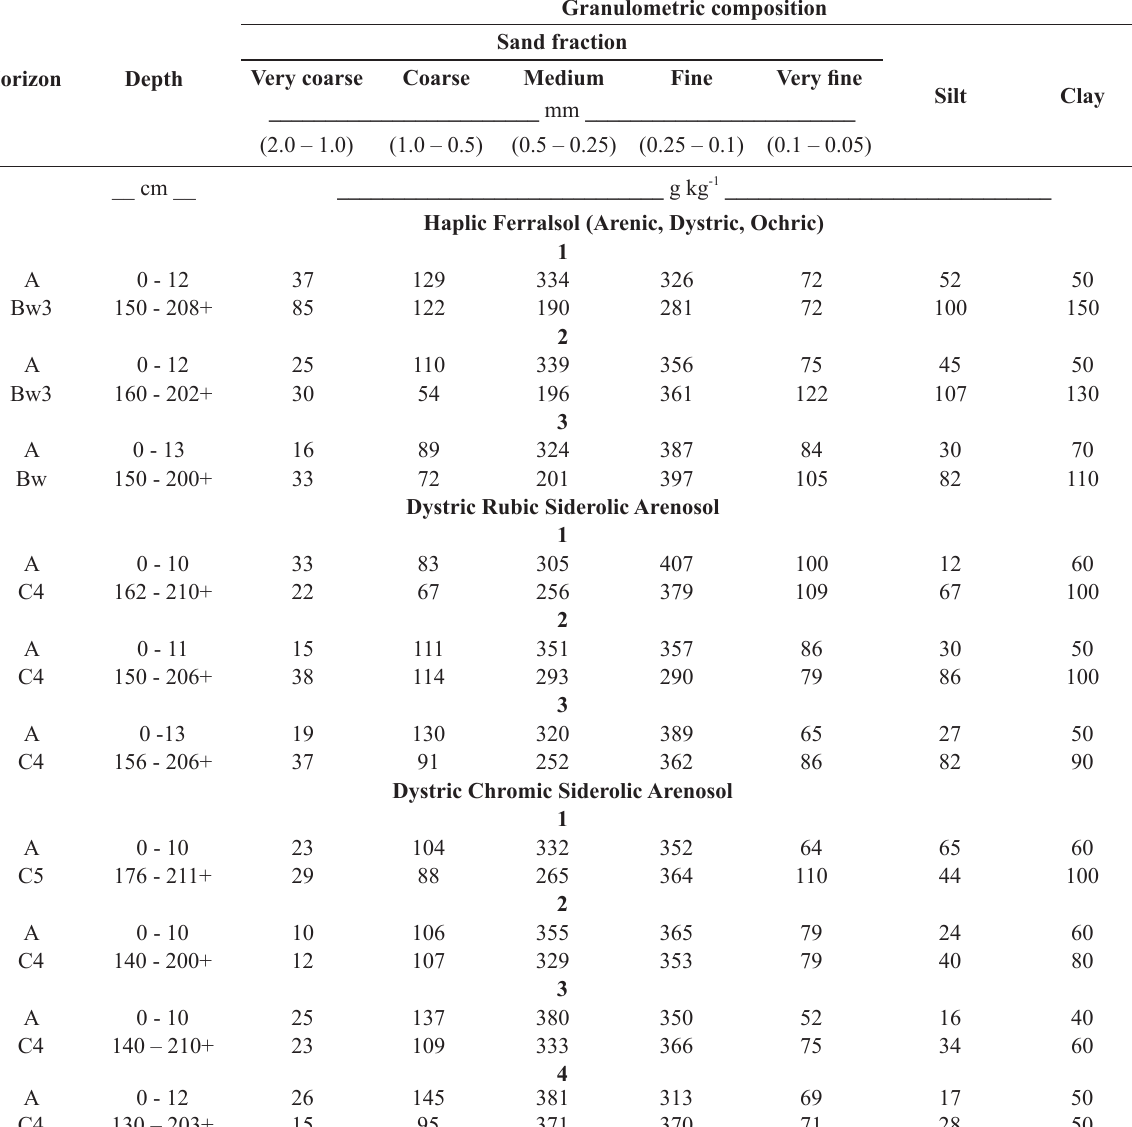
Granulometric composition of sandy soils in the municipality of Glória, Bahia state, Brazil, including sand fractionation according to the Soil Science Division Staff